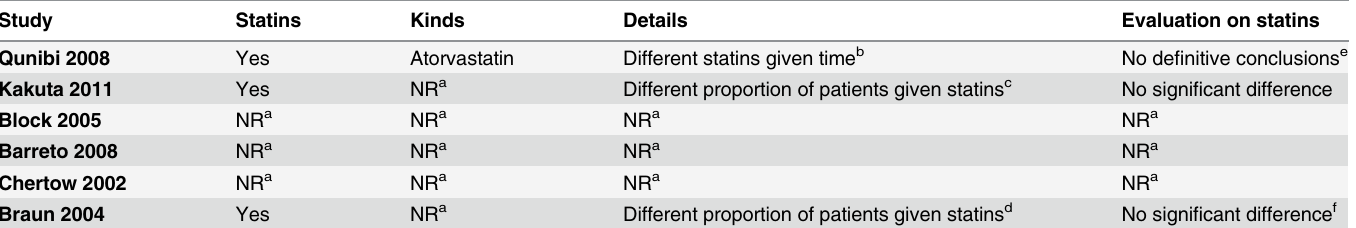
Table 3. Details of the use of